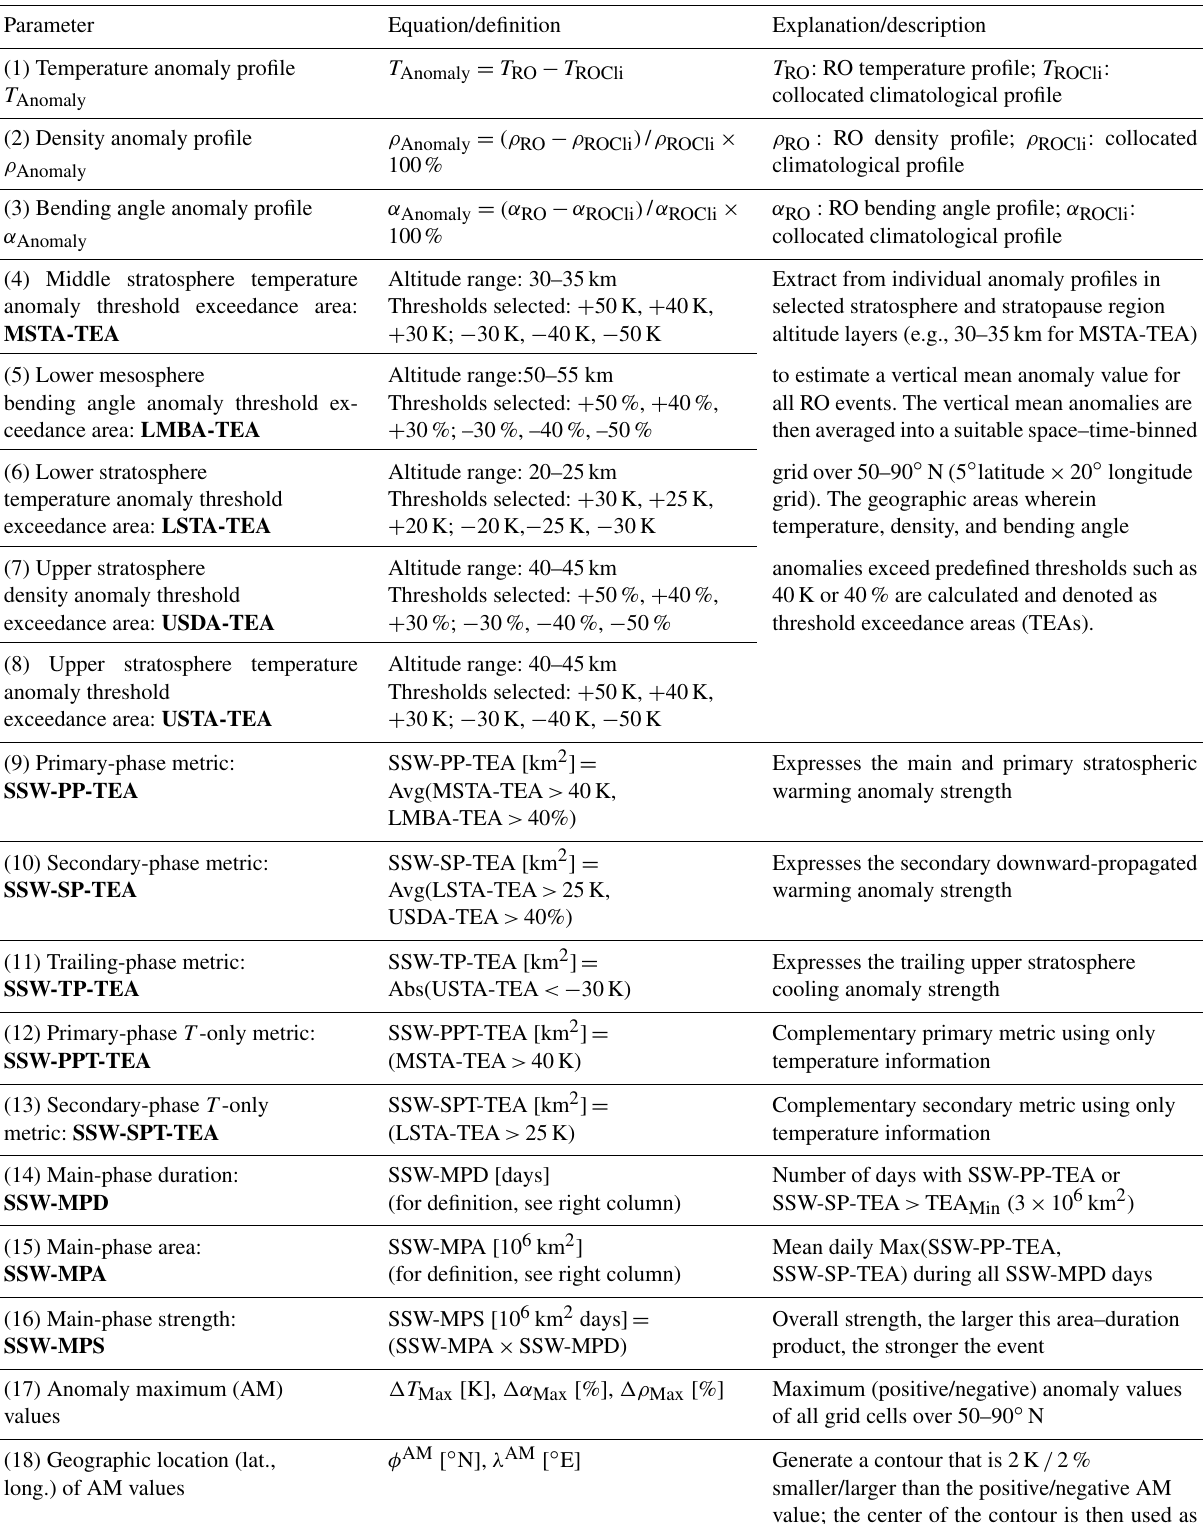
Table 1. Basic parameters and methodology of the new SSW monitoring approach (all parameters (4)–(18) updated daily; the boldfaced font in (4)–(16) shows the key parameters for the monitoring as also shown in Figs. 6 and